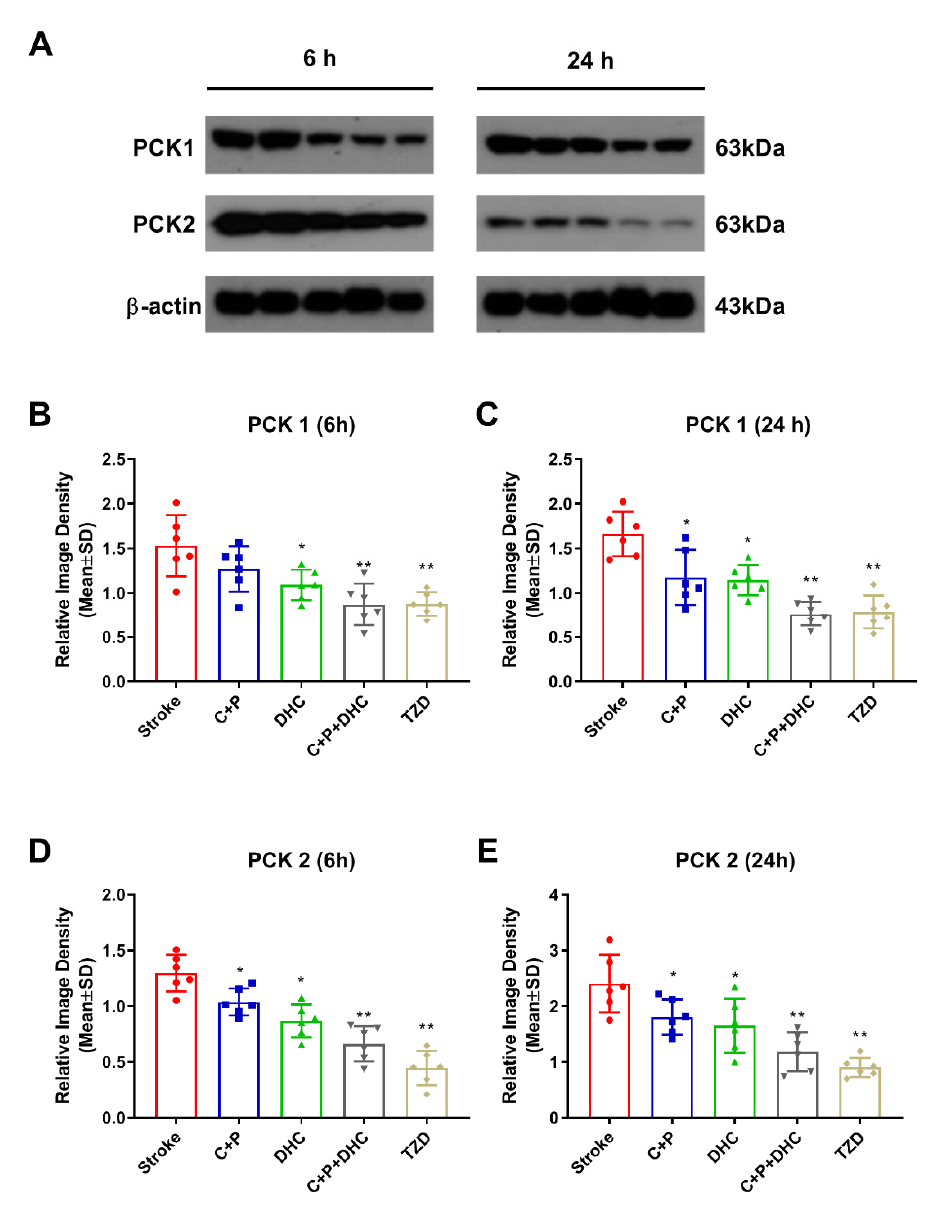
Figure 6. Effect of pharmacological hypothermia on gluconeogenic enzymes. ( A ) Representative Western blot bands of gluconeogenic enzymes. PCK1 ( B , C ) and PCK2 ( D , E ) levels were significantly reduced by pharmacological hypothermia and TZD. Data are presented as mean ± SD, * p < 0.05, ** p < 0.01, as compared to stroke group ( n = 5).